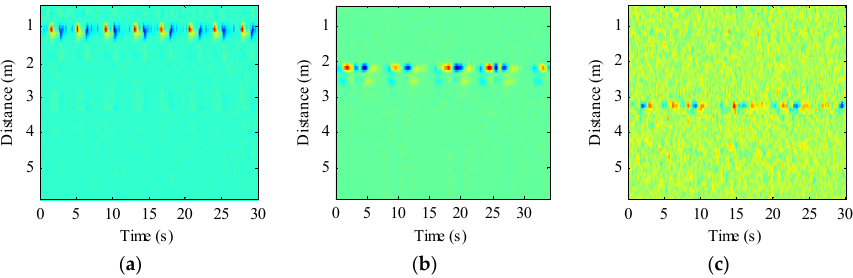
Figure 6. Results after the variational mode decomposition (VMD). (a) The waveform of VIMF1; (b) The spectrum of VIMF1; (c) The waveform of VIMF2; (d) The spectrum of VIMF2.